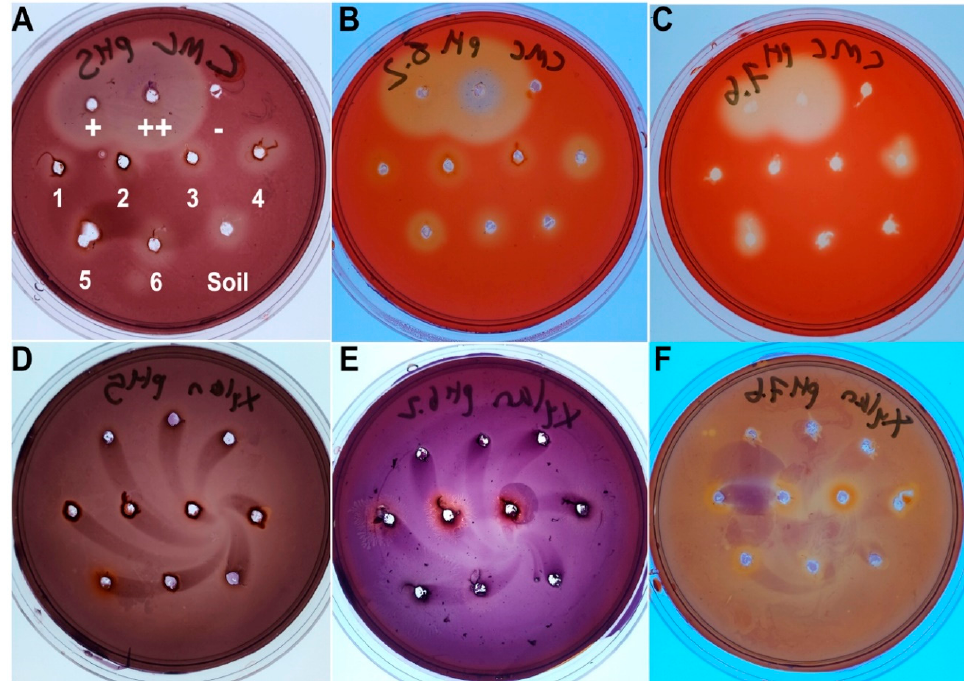
Figure 2. Cellulase and xylanase tests of the Oryctes rhinoceros gut at different pHs. Clearings in the Congo Red-stained plates indicate positive cellulase or xylanase activity. The positive control is commercial cellulase from Asperillus niger (TCI, Japan): (+) is 0.029 U, (++) is 0.29 U. Note that this cellulase is not xylanolytic. The negative control (-) is deionized water. The numbering corresponds to the sections in Figure 1, with 1–3 from the midgut and 4–6 from the hindgut. The other sample is